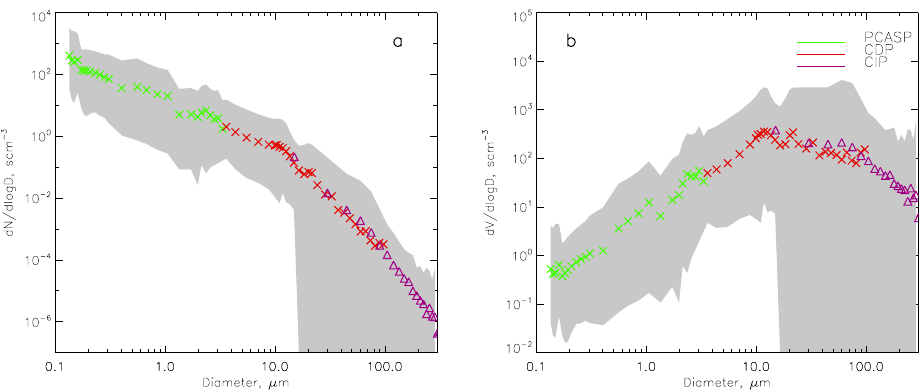
Fig. 5. Mean size distributions measured during Fennec 2011 horizontal legs, for number distribution (a) and volume distribution (b) . Data from the PCASP (green crosses), CDP (red crosses) and CIP (purple triangles) have been used. Grey shading represents minimum and maximum values measured during Fennec horizontal legs.